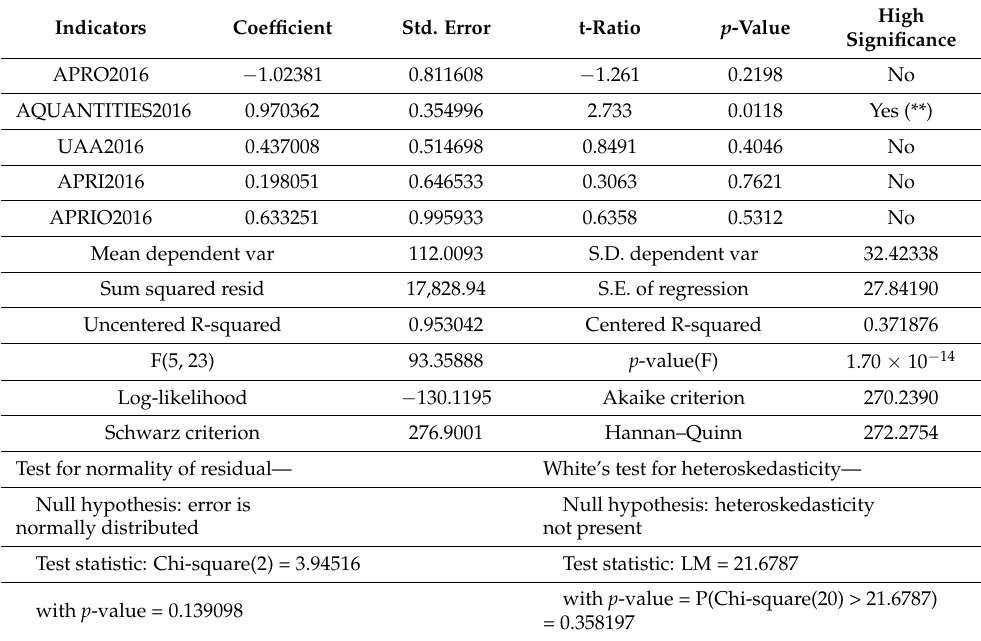
Table 6. Model 2016: OLS, using observations 1–28 (Dependent variable: AINCOME2016).